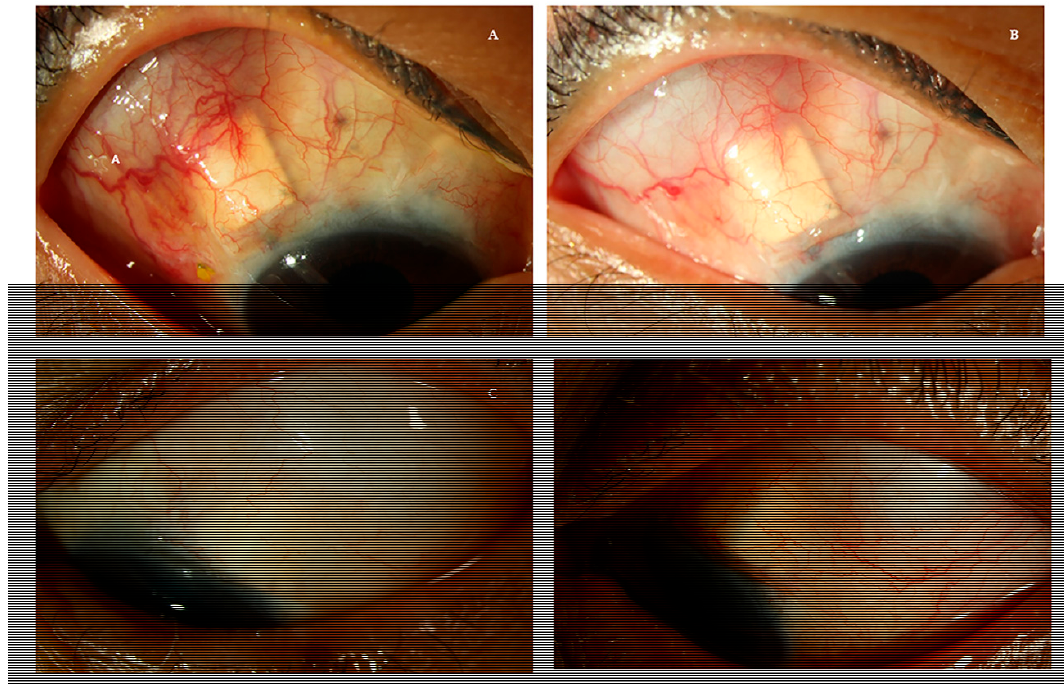
Figure 4. Photographs of vascularity changes around the AGV including the bleb and the plate margin in the AS group and PG analogs group in a short -term period. ( A , C ) were taken at the onset of the hypertensive phase and ( B , D ) were taken two to four weeks after the initiation of the medication. ( A , B ) A 43-year-old female with uveitic glaucoma after AGV implantation started AS (timolol–dorzolamide fixed combination) and the vascularity around AGV decreased. ( C , D ) A 69-year-old male with neovascular glaucoma began to use a PG analog (bimatoprost) and exhibited increased vascularity.